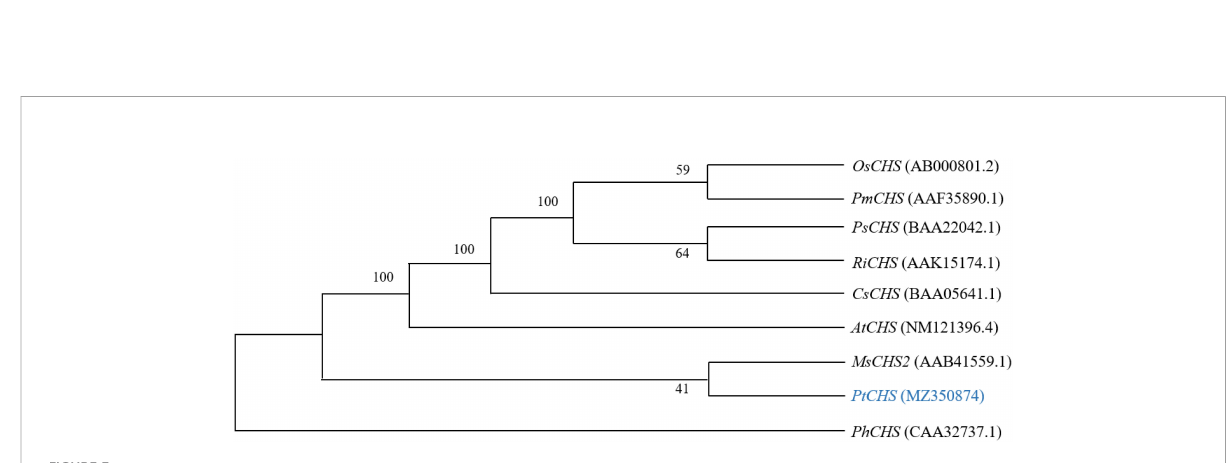
FIGURE 3 The phylogenetic tree analysis of PtCHS and CHS genes of other